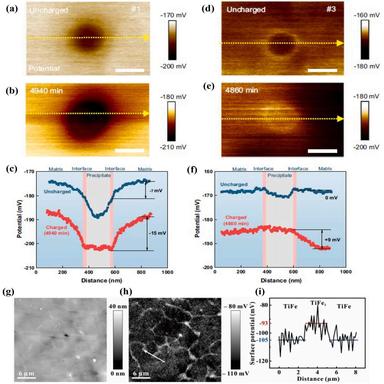
(a, b, d, and e) Surface potential images and (c, f) corresponding line profiles along yellow dashed arrows on the Ti2CS nanoprecipitates (a-c) marked as #1 and (d-f) marked as #3 of high strength low alloy martensitic steel; (a, d) as-grown state and (b, e) after 4940 min exposure to hydrogen. The scale bars indicate 200 nm. (g) SPM topography image, (h) corresponding surface potential image, and (i) line profile along the white arrow in (h), of Ti-Fe-Zr alloys. (a–f) Reproduced with permission from .](#pa